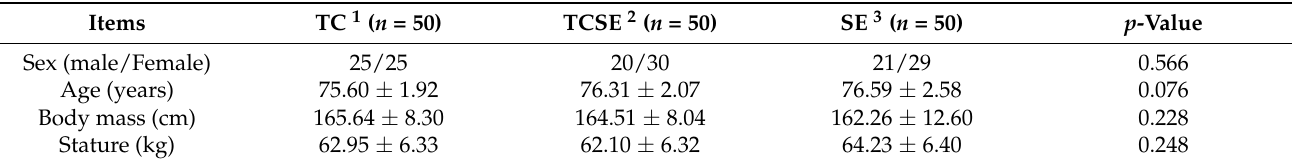
Table 1. Baseline demographic characteristics of the